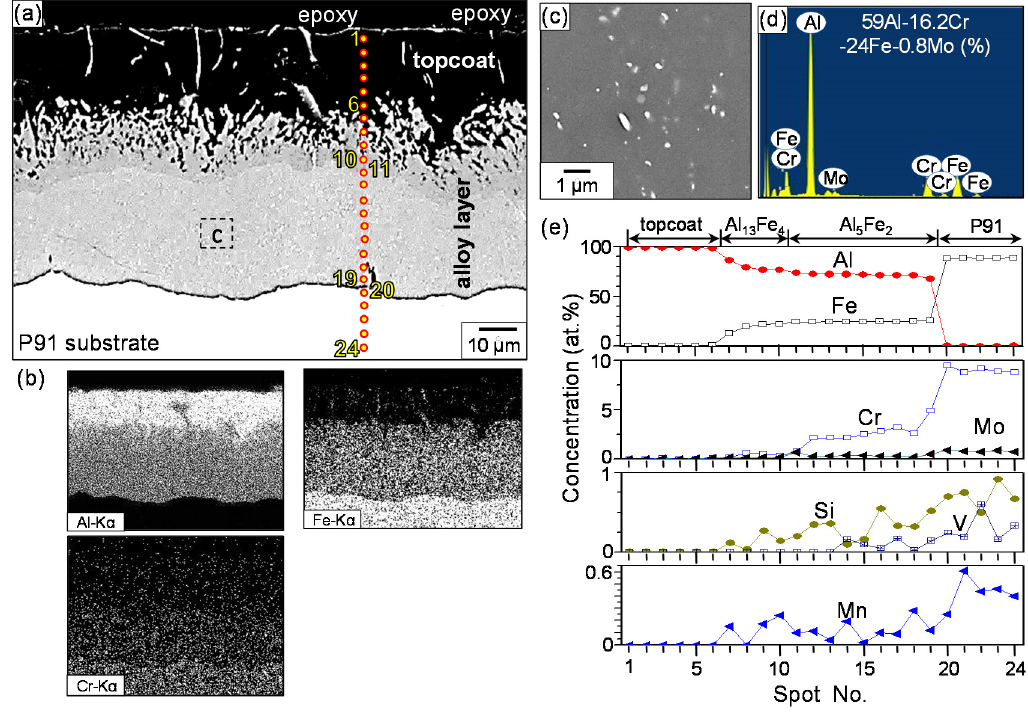
Figure 2. Al hot ‐ dipped P91 steel. ( a ) SEM cross ‐ sectional back ‐ scattered electron (BSE) image (etched); ( b ) EDS maps of (a); ( c ) enlarged image of the rectangular area marked in (a); ( d ) EDS spectrum of white particles shown in (c); ( e ) EDS concentration profiles along the spots 1–24 marked in (a).